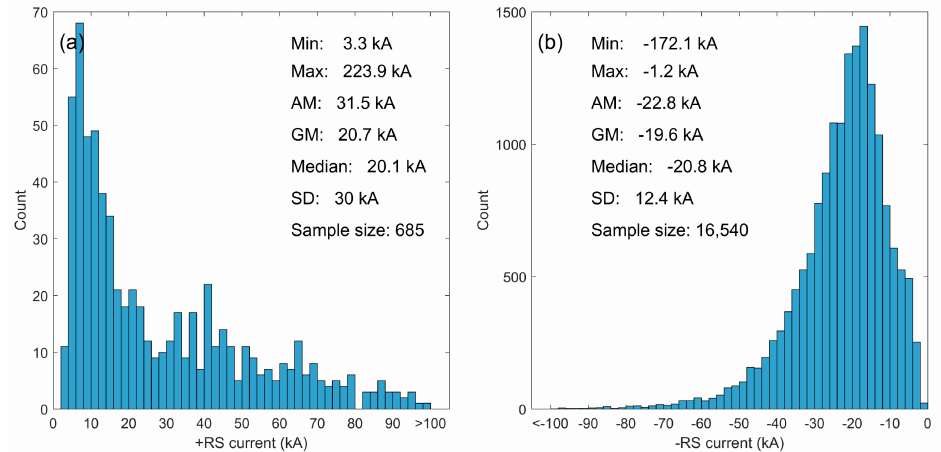
Figure 9. Histograms of RS peak currents: ( a ) positive RS; ( b ) negative RS; Here, Min, Max, AM, GM, and SD are abbreviations for Minimum, Maximum, Arithmetic mean, Geometric mean, and Standard deviation, respectively. Table 5. Comparison of RS currents among different studies.